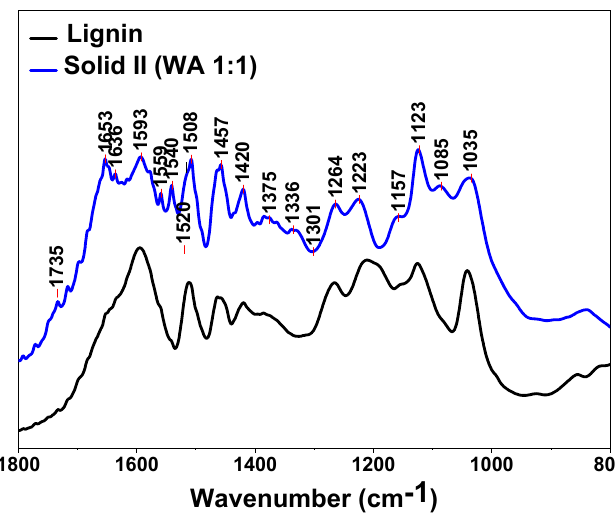
Figure 4. FTIR spectra of Solid II and commercial lignin.